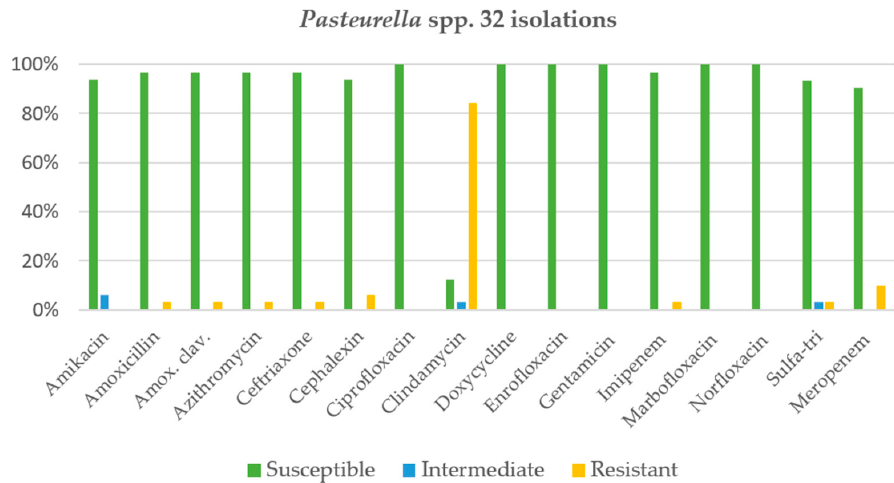
Figure 3. Activity of antimicrobials against Pasteurella spp. in 32 isolations.